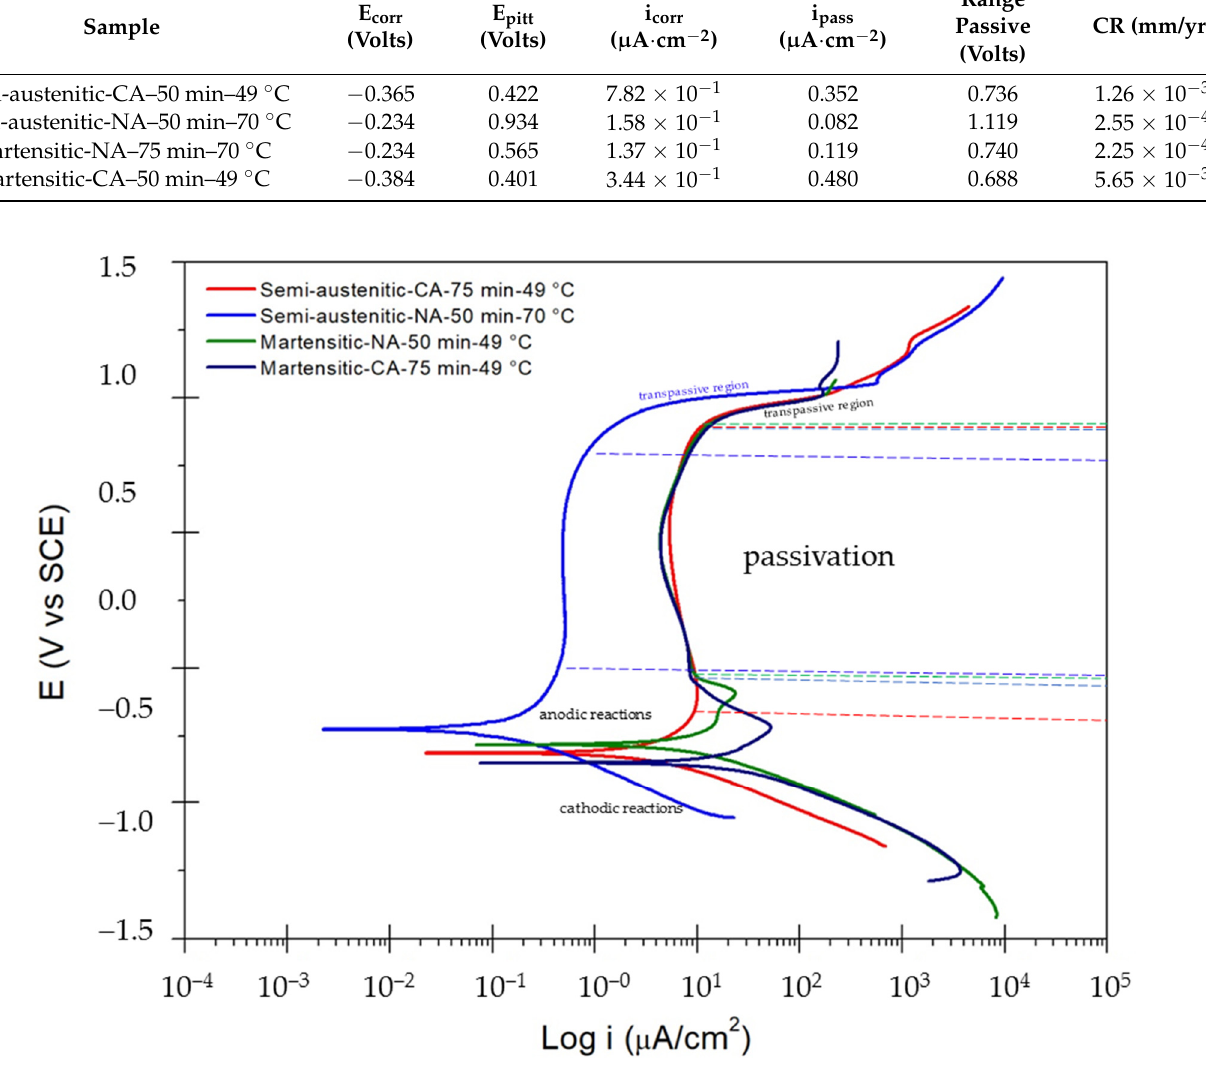
Figure 4. Potentiodynamic polarization curves for passivated martensitic and semi-austenitic. PHSS in 1 wt.% H 2 SO 4 solution. Table 5. Parameters obtained by PP for passivated martensitic and semi-austenitic. PHSS in 1 wt.% H 2 SO 4 solution.